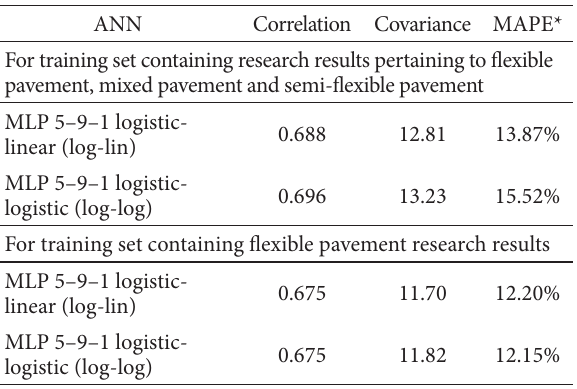
Table 3. Values of selected statistics – ANN testing ANN